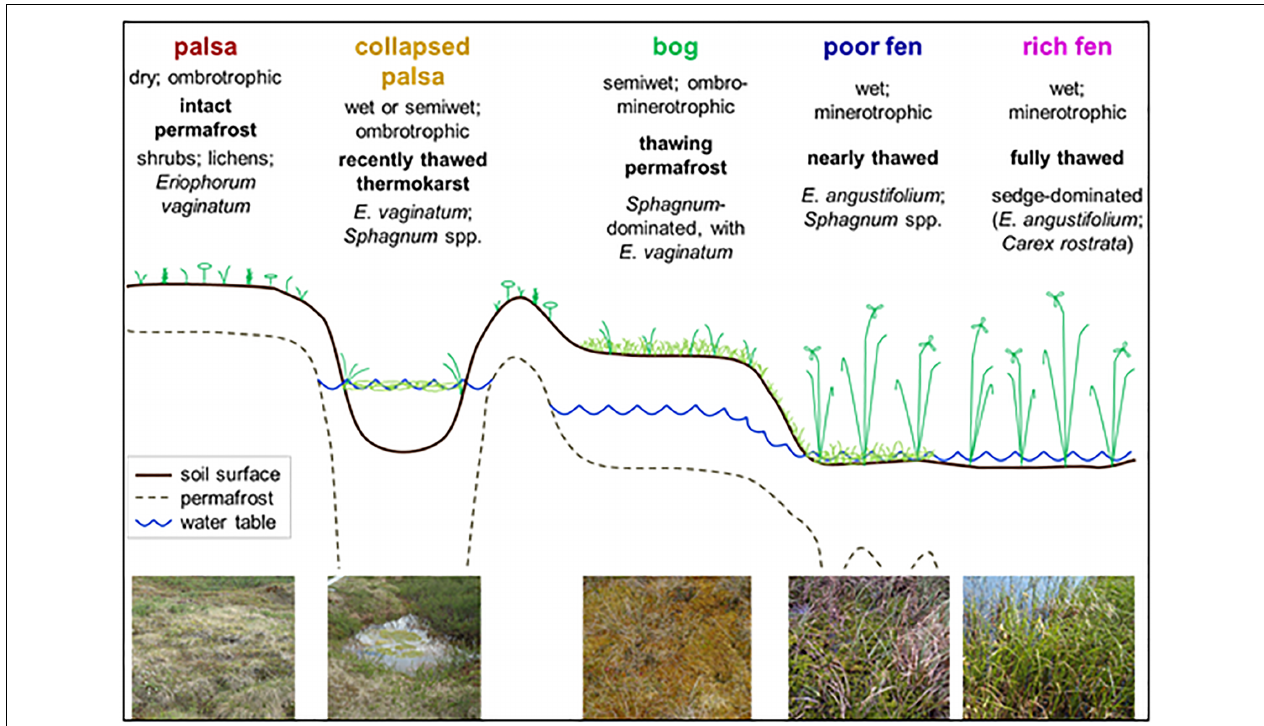
FIGURE 1 | Schematic of the Stordalen chronosequence from the dry palsas sitting atop intact permafrost through recently thawed, inundated, collapse features, more mature, but drier, bogs and fully thawed inundated fens. This figure is from Hodgkins (2016) (used with